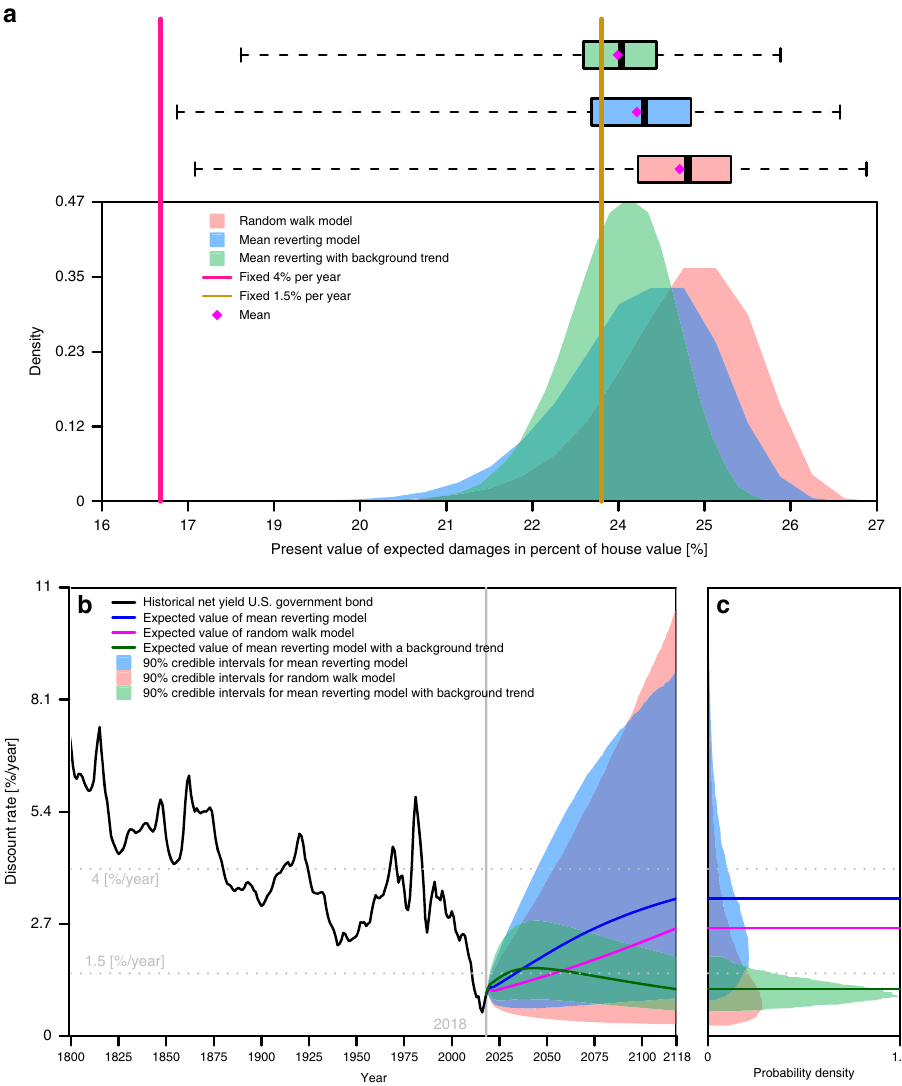
Fig. 2 Impact of discount rate uncertainty on expected damages. a Impact of different discount rate models on estimates of the net present value of expected damages for the hypothetical house (1500 ft 2 with a worth of $300 K and with the lowest fl oor at four feet below the base fl ood elevation). Box plots show the dispersion of the damage estimates for the three considered stochastic models. The whiskers extend to the data extremes. Boxplot centerline is the median. b Historical (1800 – 2018) and projected (2019 – 2118) discount rate time series. The shaded areas indicate the 90% credible interval of projected discount rates. c Probability density function (colored shaded areas) of discount rate models for 2118. Expected values are shown by solid